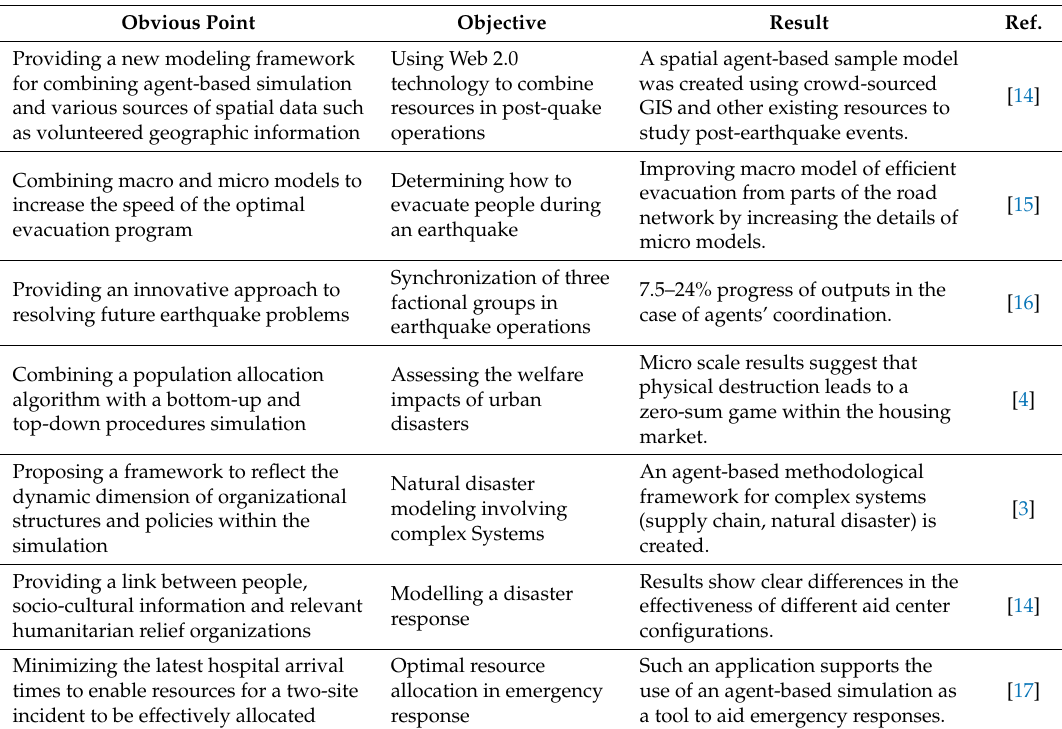
Table 1. Agent-based simulations conducted in disaster